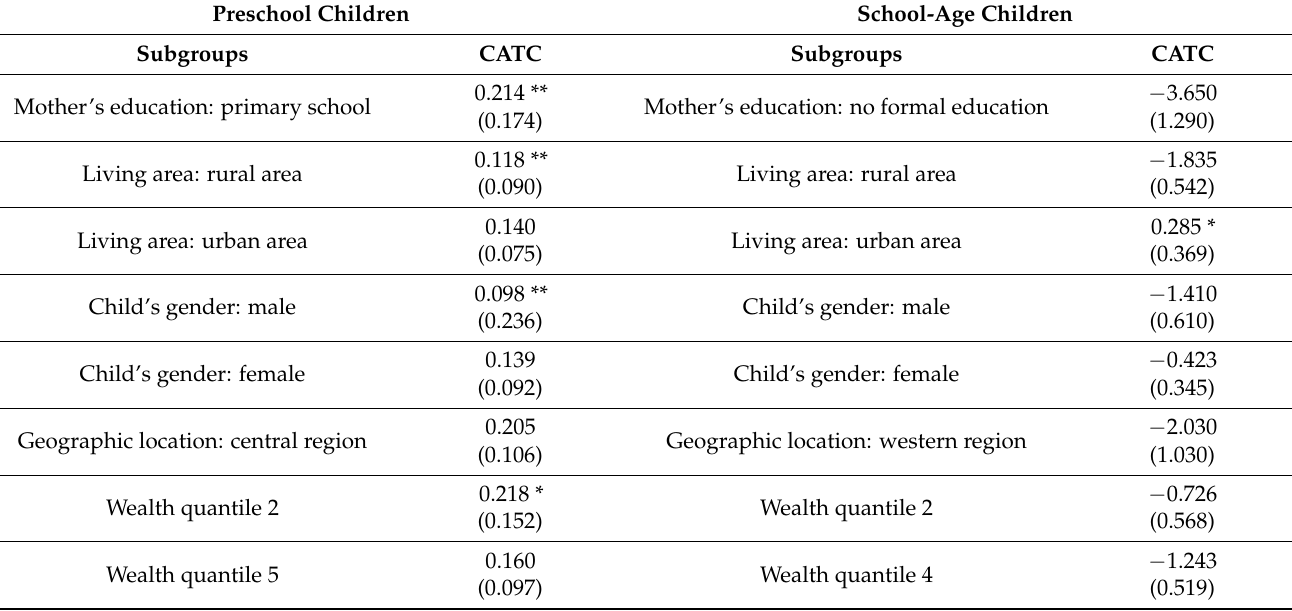
Table 4. Estimated conditional average treatment effects for subgroups discovered by the causal forest